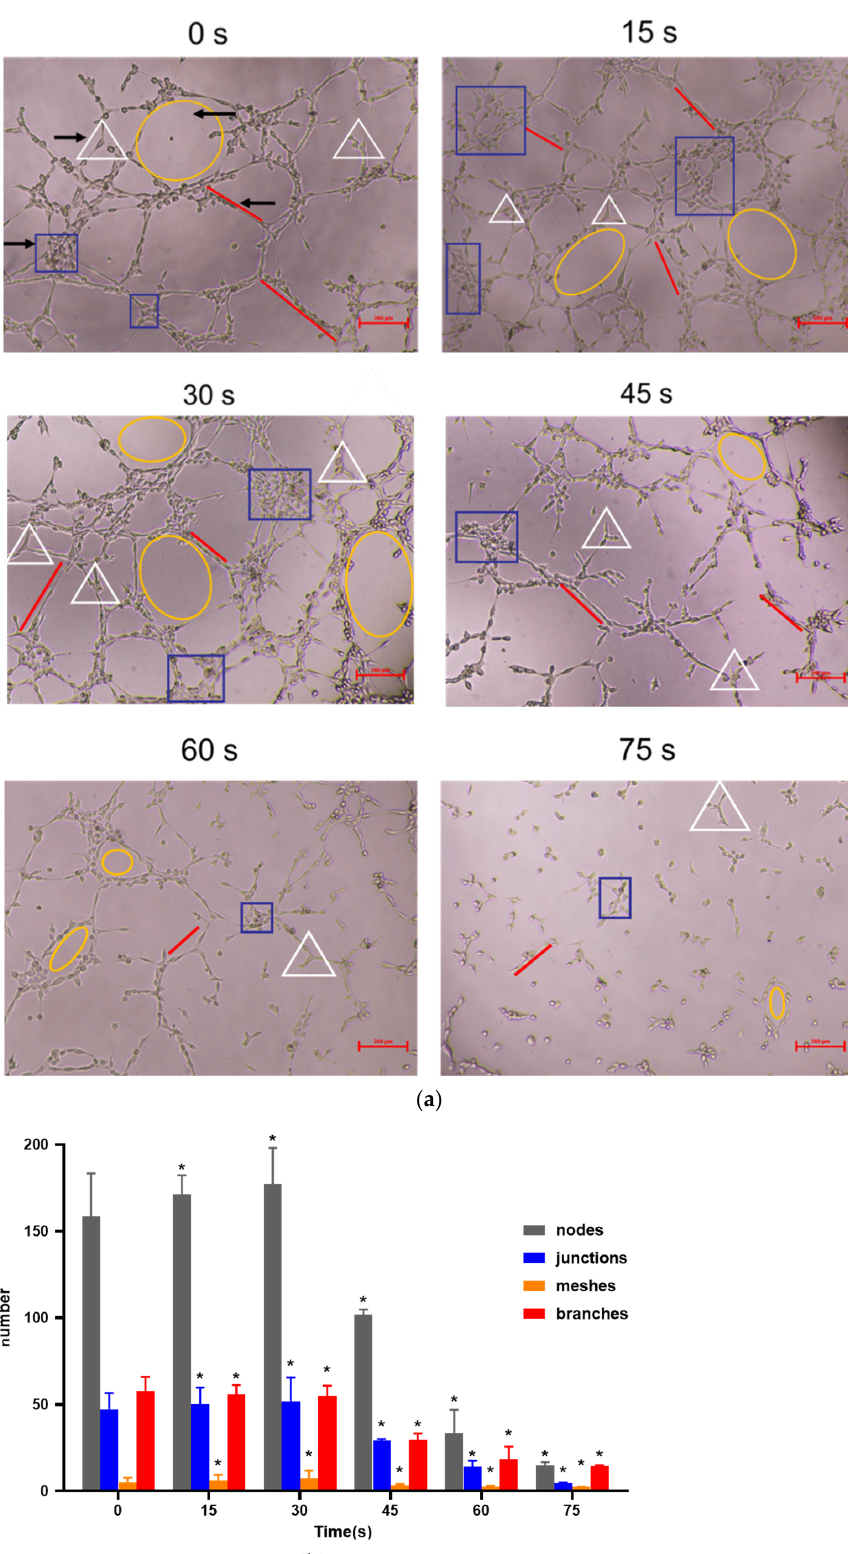
Figure 3. ( a ) Photo of in vitro angiogenesis of HUVECs treated with PAM and after 6 h of incubation (40×). Triangles indicated the nodes, squares indicated the junctions, circles indicated the meshes, and lines indicated the branches. ( b ) Statistical results about the number of nodes, junctions, meshes and branches in different groups, * compared with control group (0 s) p < 0.05.